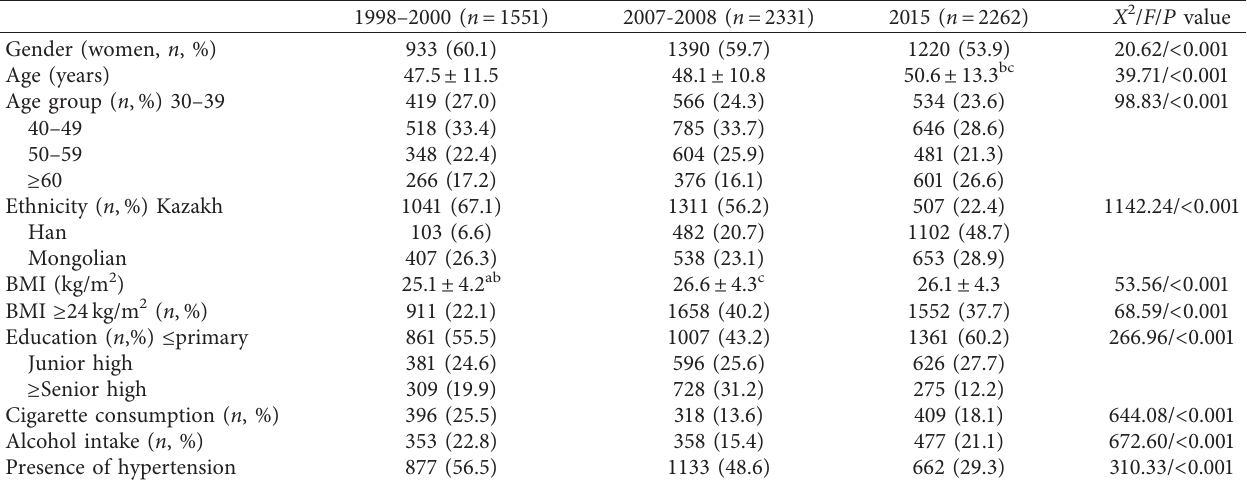
Table 1: Characteristics of study population by years of the surveys.